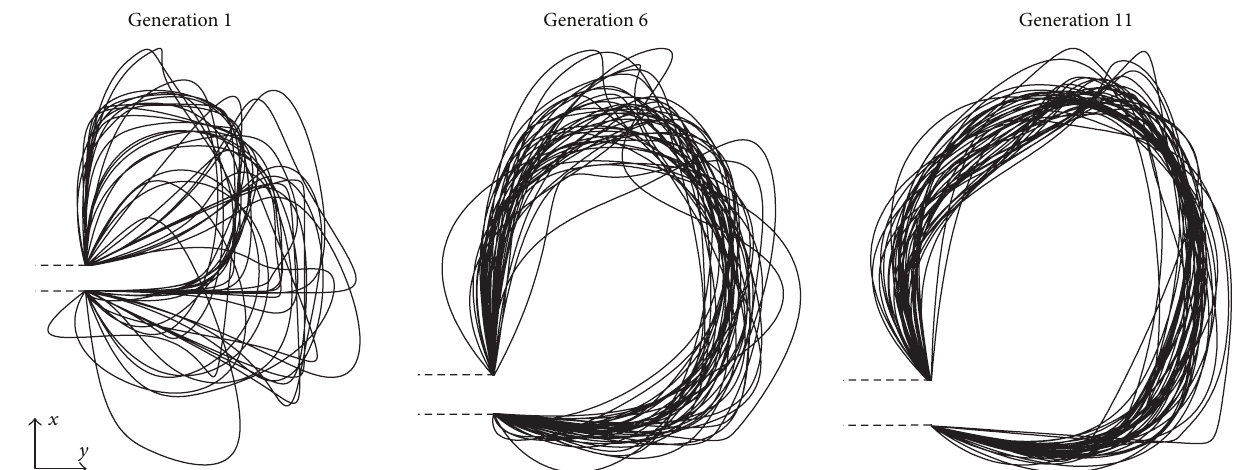
Figure 12: Cross-sectional volute shapes for different generations during the optimization.